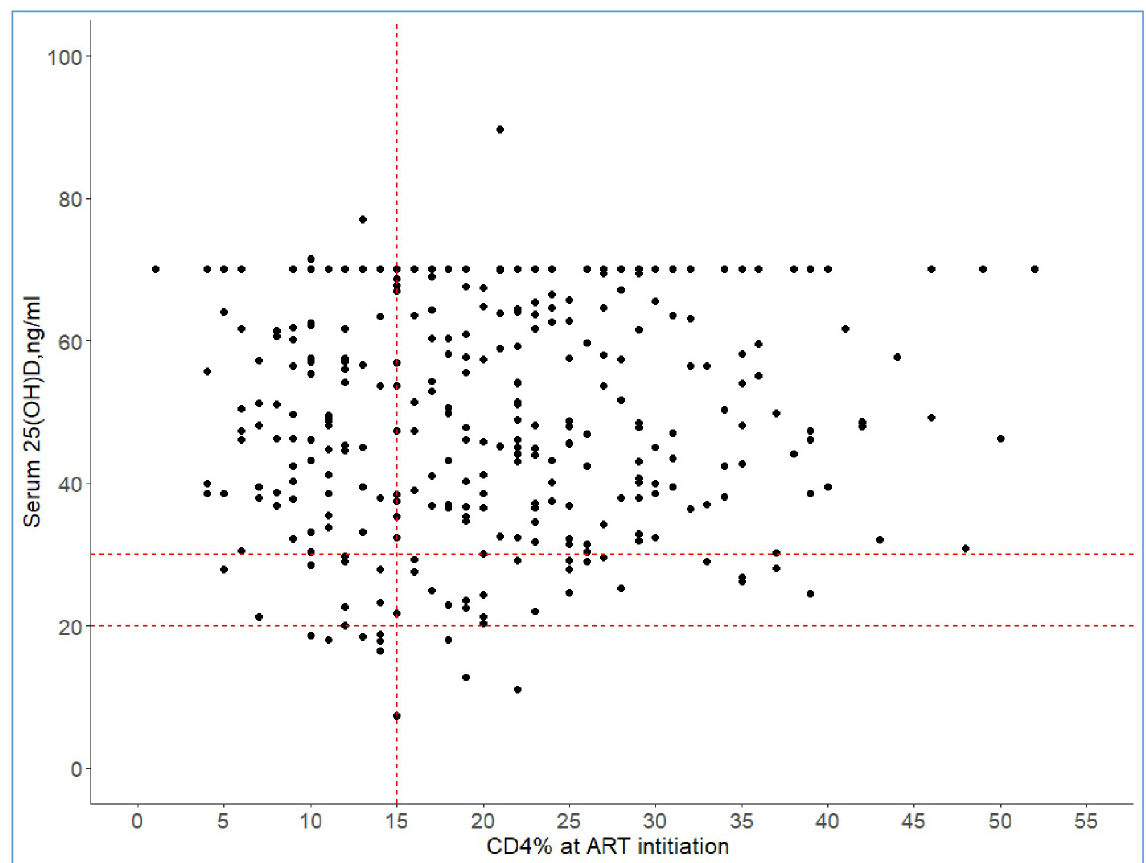
Fig 2. A graph of serum 25(OH)D against CD4% at ART initiation. The horizontal dotted lines show the 25(OH)D level at 20 ng/ml and at 30 ng/ml. The vertical doted line denotes the CD4% at 15% level. P value was calculated using chi square test comparing CD4% � 15 and > 15 with 25(OH)D < 20 ng/ml and